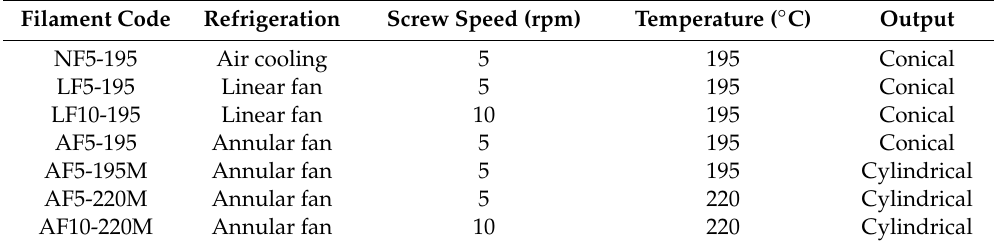
Table 2. Operational parameters for filament extrusion.